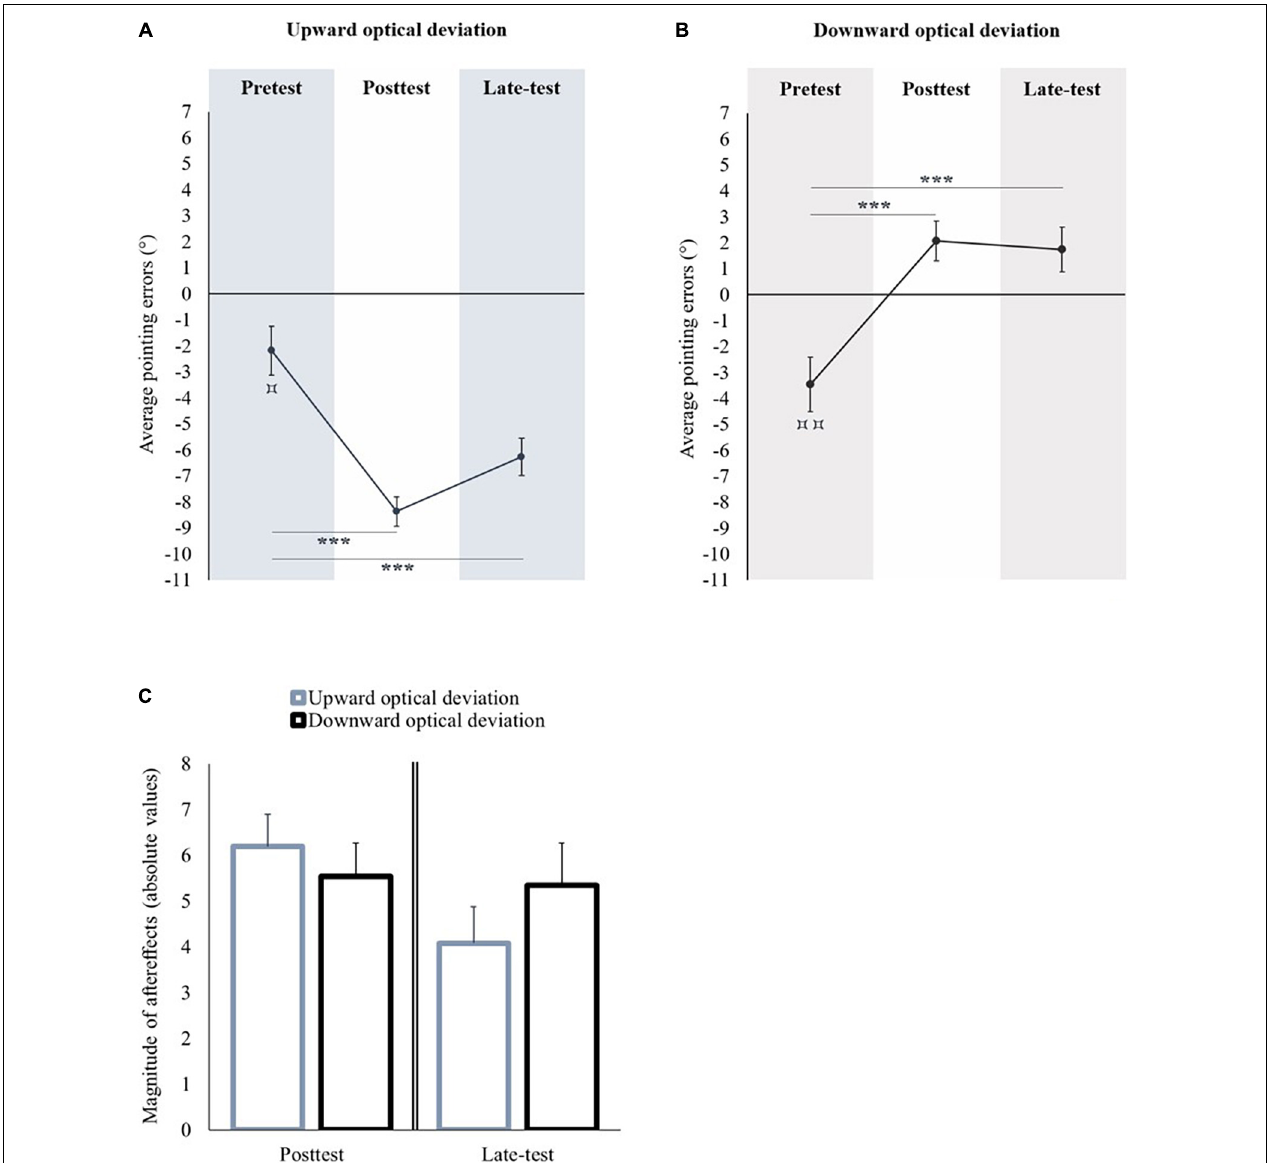
FIGURE 5 | Sensorimotor aftereffects of vertical prism adaptation. Panel (A) displays sensorimotor aftereffects before (pretest), immediately after (posttest) an upward optical deviation, and at the end of the experiment (late-test). Panel (B) displays the sensorimotor aftereffects before (pretest), immediately after (posttest) a downward optical deviation, and at the end of the experiment (late-test). Panel (C) displays the absolute values of sensorimotor aftereffects occurred following upward and downward prism adaptations in the posttest (left part) and in the late-test (right part). *** p < 0.001. Comparison of the pretest to 0: p < ◊◊